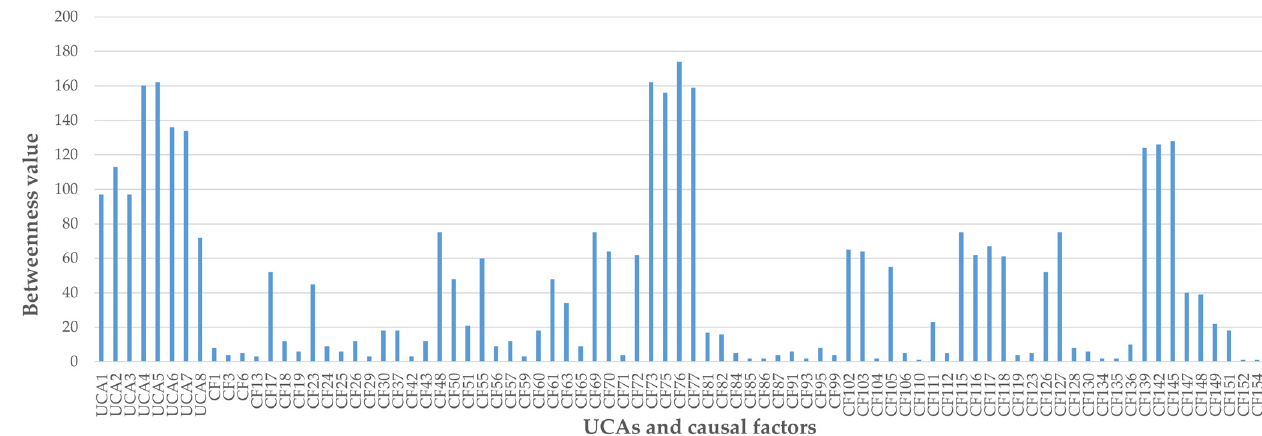
Figure 7. The betweenness value of UCAs and causal factors.